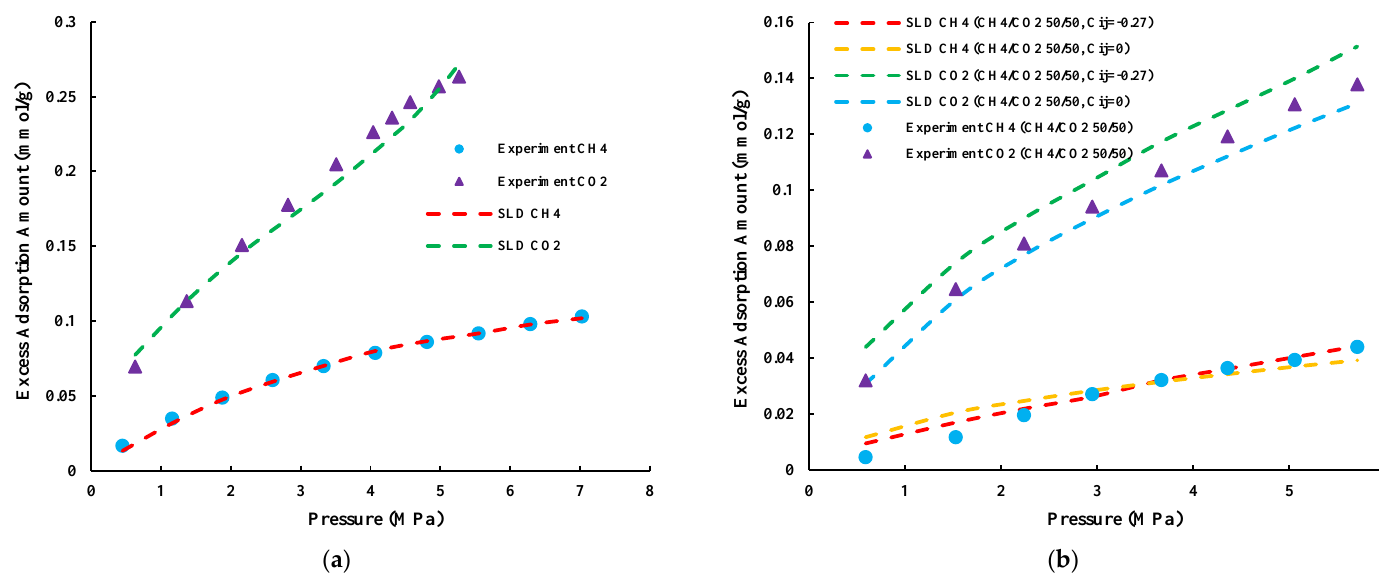
Figure 2. Adsorption isotherms of CH 4 , CO 2 , and 50/50 CH 4 /CO 2 mixture in shale at 313.15 K. ( a ) Pure gas. ( b ) Gas mixture (CH 4 /CO 2 50/50).